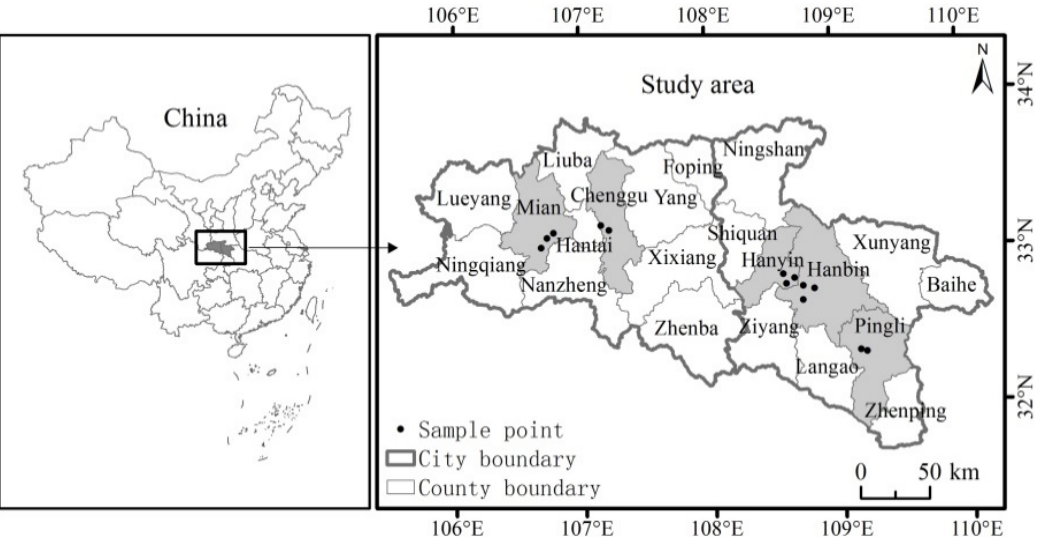
Figure 1. Research area and sampling point distribution.